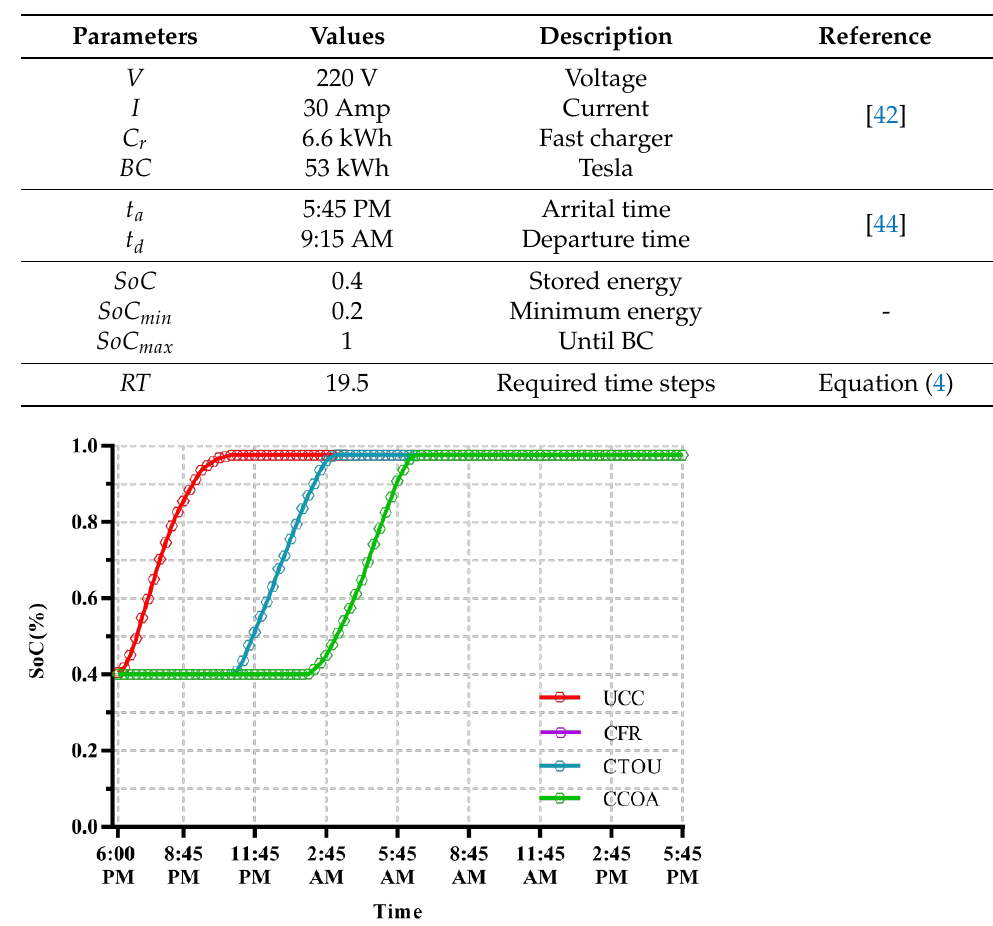
Table 1. Input parameters for an individual charging scenario.